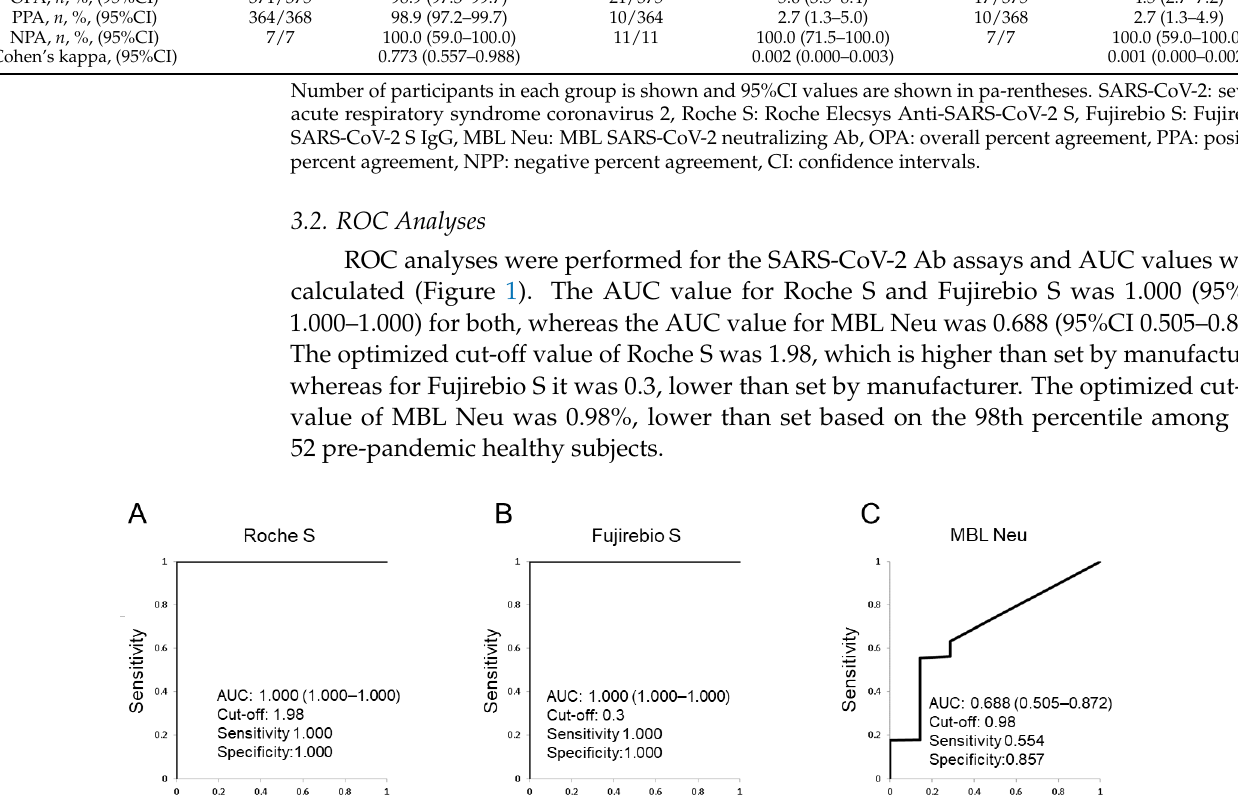
Table 3. Concordance between SARS-CoV-2 Ab detection assays.